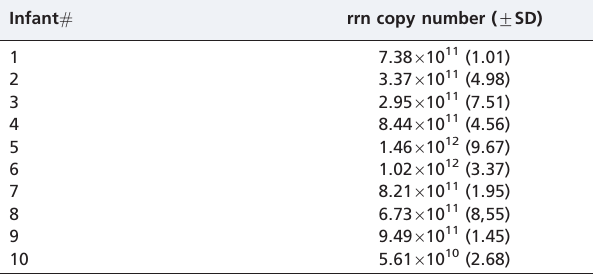
Table 4 - Bifidobacterium counts obtained through real- time PCR in the 30-day-old